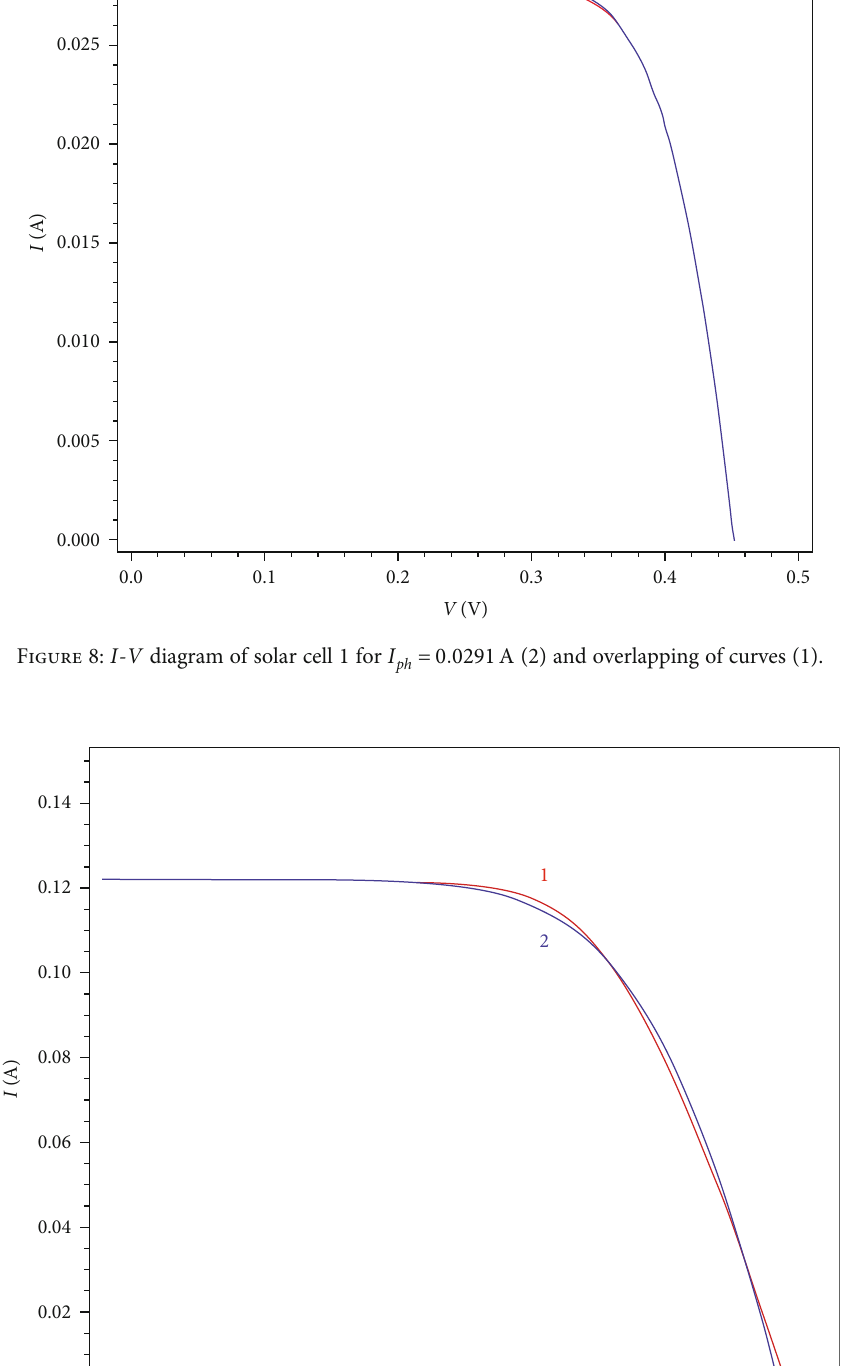
Figure 9: I - V diagram of solar cell 1 for I